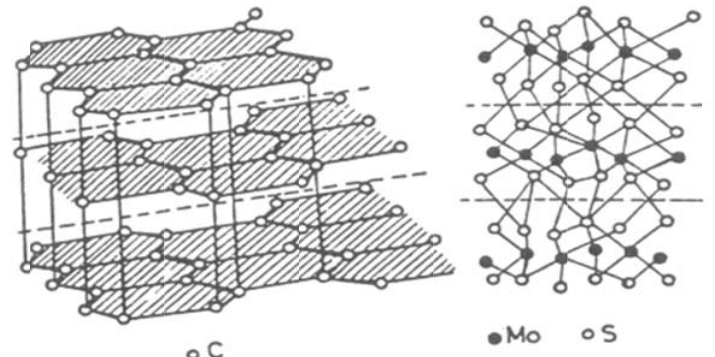
Fig. 11 Crystallo-chemical structure of graphite and molybdenite.